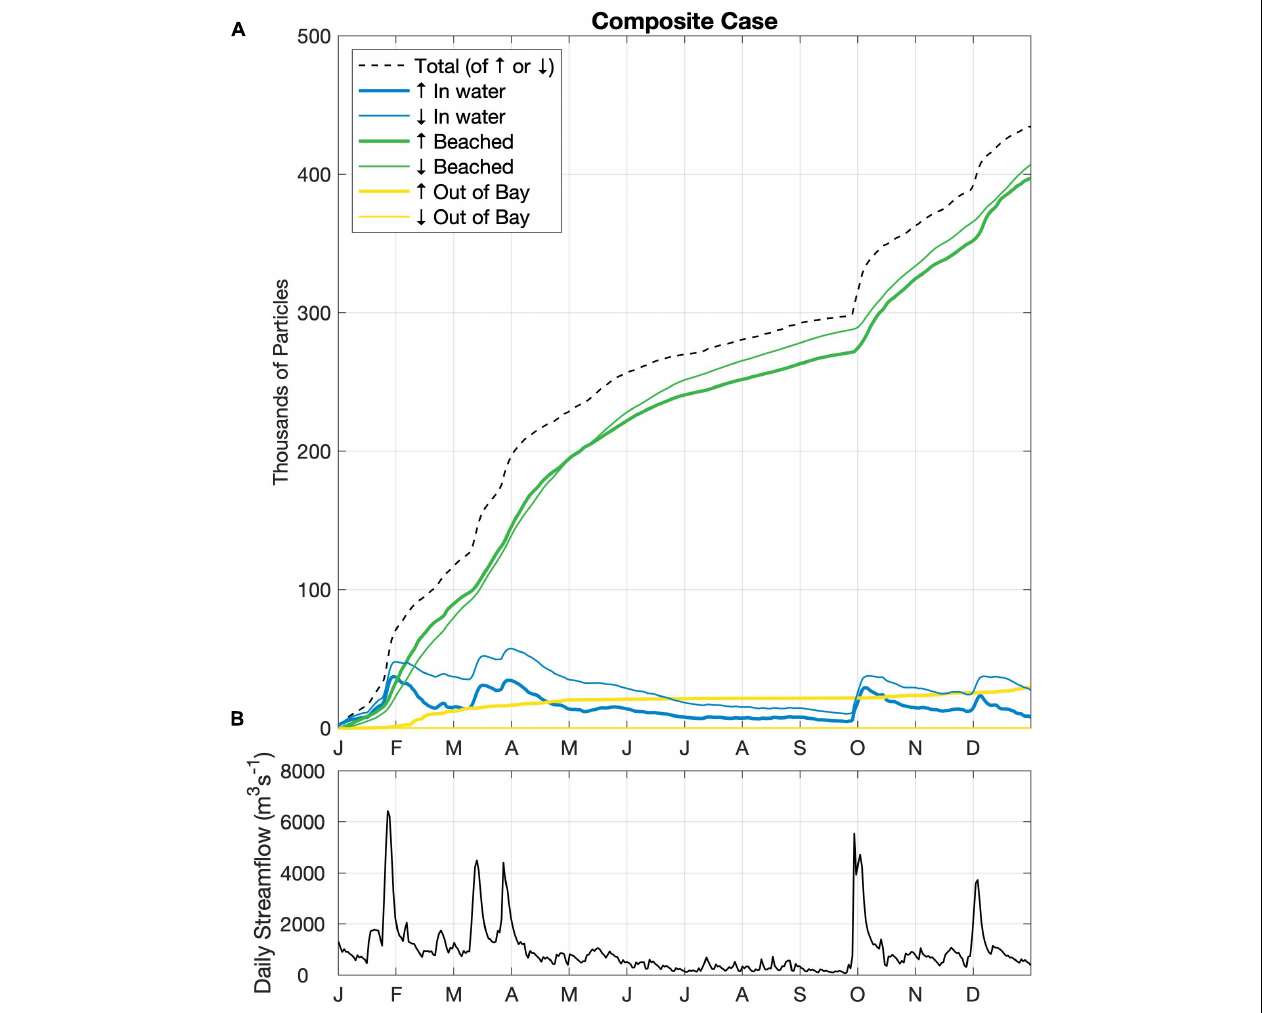
FIGURE 4 | (A) Daily time series of the individual inventories of particles (in water inside the Bay beached inside the Bay, or out of Bay) and their total in the composite simulation for all rivers combined. Line thickness indicates whether the particles are floating (thick) or sinking (thin), and the black dashed line represents the sum of either all of the floating ( ↑ ) or sinking ( ↓ ) particles with time, as equal amounts of each were added throughout the simulation. (B) Daily time series of streamflow that enters the Chesapeake Bay in ChesROMS, obtained from Chesapeake Bay Program Watershed Model (Shenk and Linker, 2013; Easton et al., 2017); the cumulative sum of this plot is equivalent to the dashed line above, as 1 particle m − 3 is added per 1 m 3 s − 1 of daily